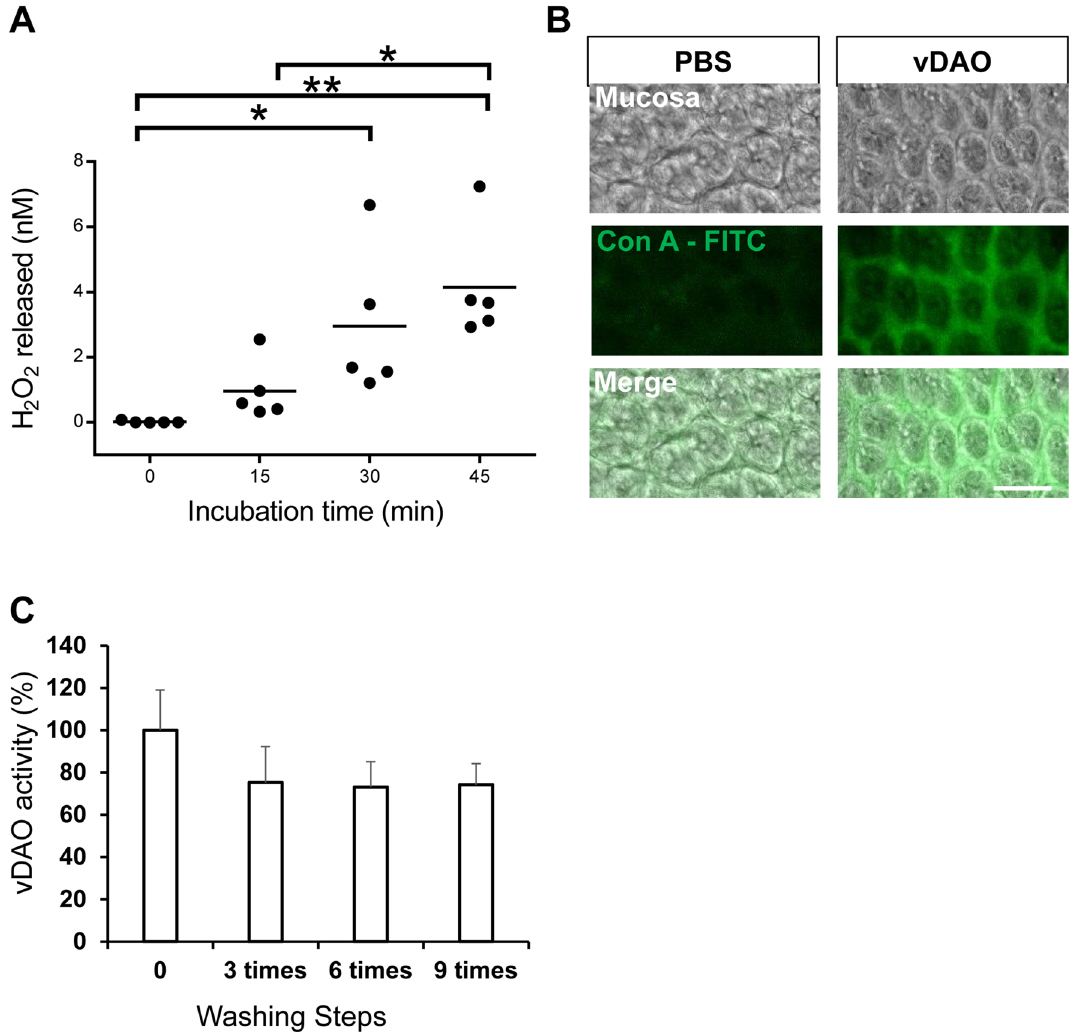
Figure 7. Retention of active vDAO on colon mucosa after rectal administration. ( A ) Analysis of vDAO- mediated release of H 2 O 2 from colon mucosa of mice that previously received vDAO by enema. ( B ) Analysis of vDAO retention by staining with FITC-labeled Concanavalin A. ( C ) Retained vDAO remains active after repeated washes (mean ± SD; n = 3–5; * P < 0.05, ** P < 0.01; one-way ANOVA multiple